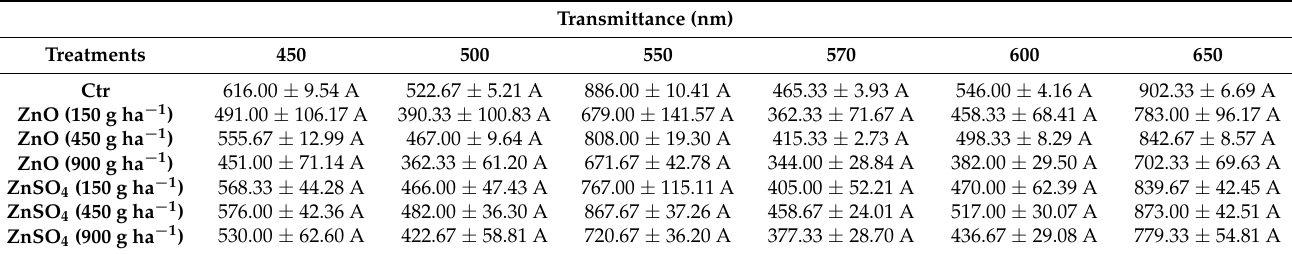
Table 5. Mean values ± SE (n = 3) of the transmittance of visible spectra in grapes of Vitis vinifera L. variety Fern ã o Pires at harvest. Letter A indicates absence of significant differences (statistical analysis using the single-factor ANOVA test, p ≤